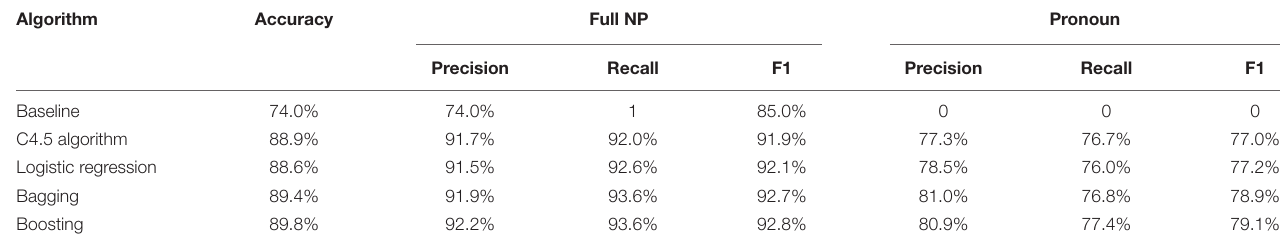
TABLE 5 | Prediction of the basic referential